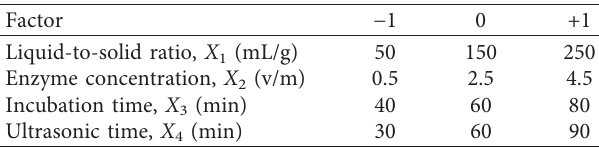
Table 1: Experimental values of the independent variables used in the Box–Behnken design